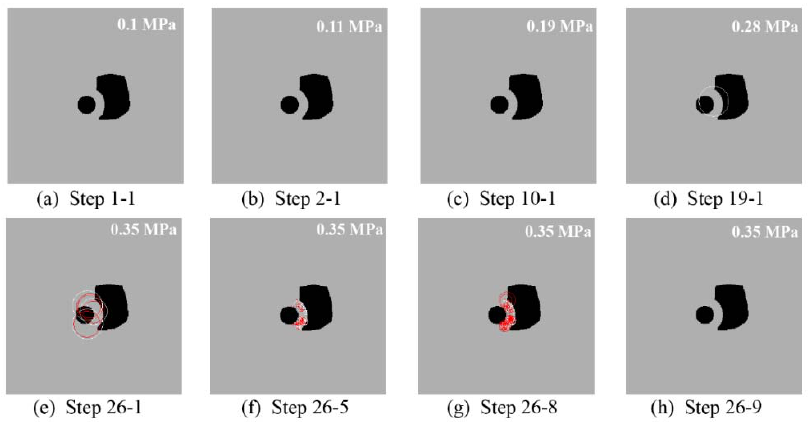
Figure 3. Acoustic emission diagram of the model shown in Figure 1 at different steps: ( a – h ).